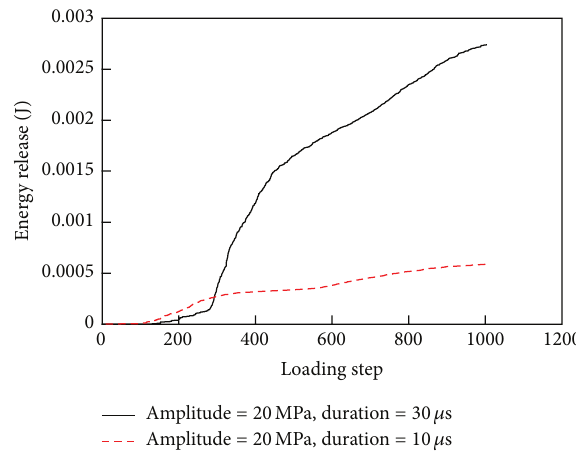
Figure 12: Variation of energy release of sample under different wavelength